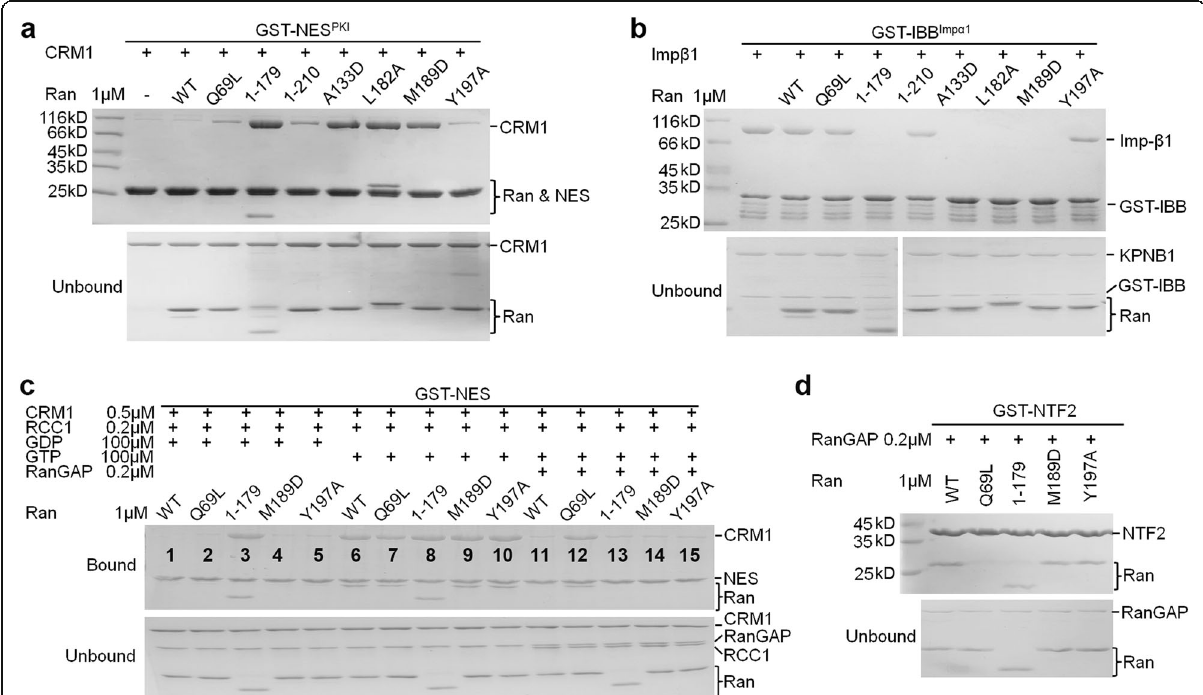
Fig. 2 Comparison of different Ran mutants ’ interaction with RCC1, RanGAP, and NTF2. a GST-NES PKI pull-down of CRM1 and different Ran proteins. b GST-IBB Imp α 1 pull-down of Imp β 1 in the presence of different Ran. RanGTP dissociates the Imp β 1-IBB complex, so less Imp β 1 means stronger Ran binding, in contrast to the CRM1 pull-down. c GST-NES PKI pull-down of CRM1 and different Ran proteins, in the presence or absence of RCC1, RanGAP, GTP or GDP. d GST-NTF2 pull-down of different Ran proteins in the presence of RanGAP. RanGAP ensures all Ran proteins are in GDP-bound form (Purified Ran Q69L is mainly